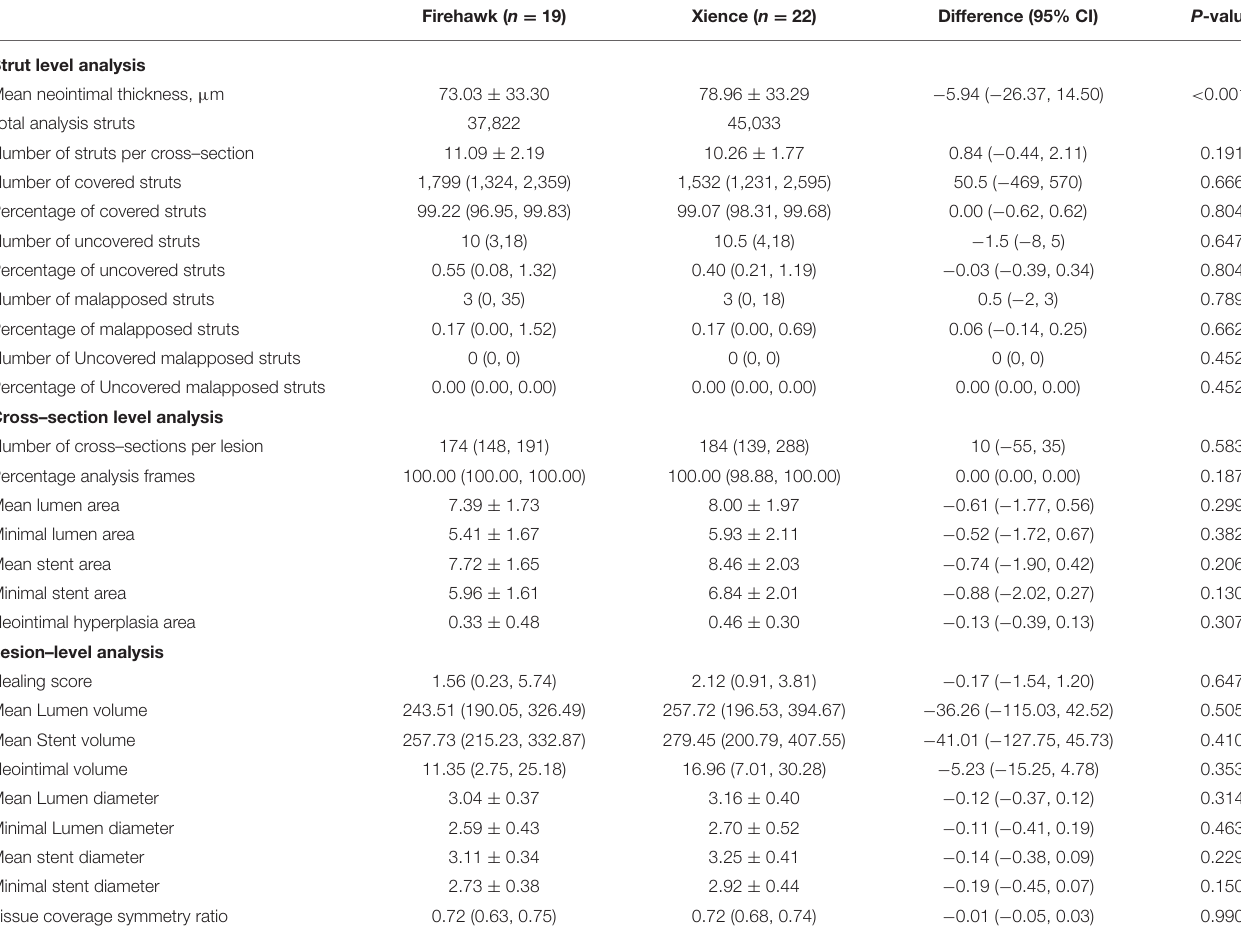
TABLE 4 | Six–month qualitative and quantitative optical coherence tomography analysis (as treated